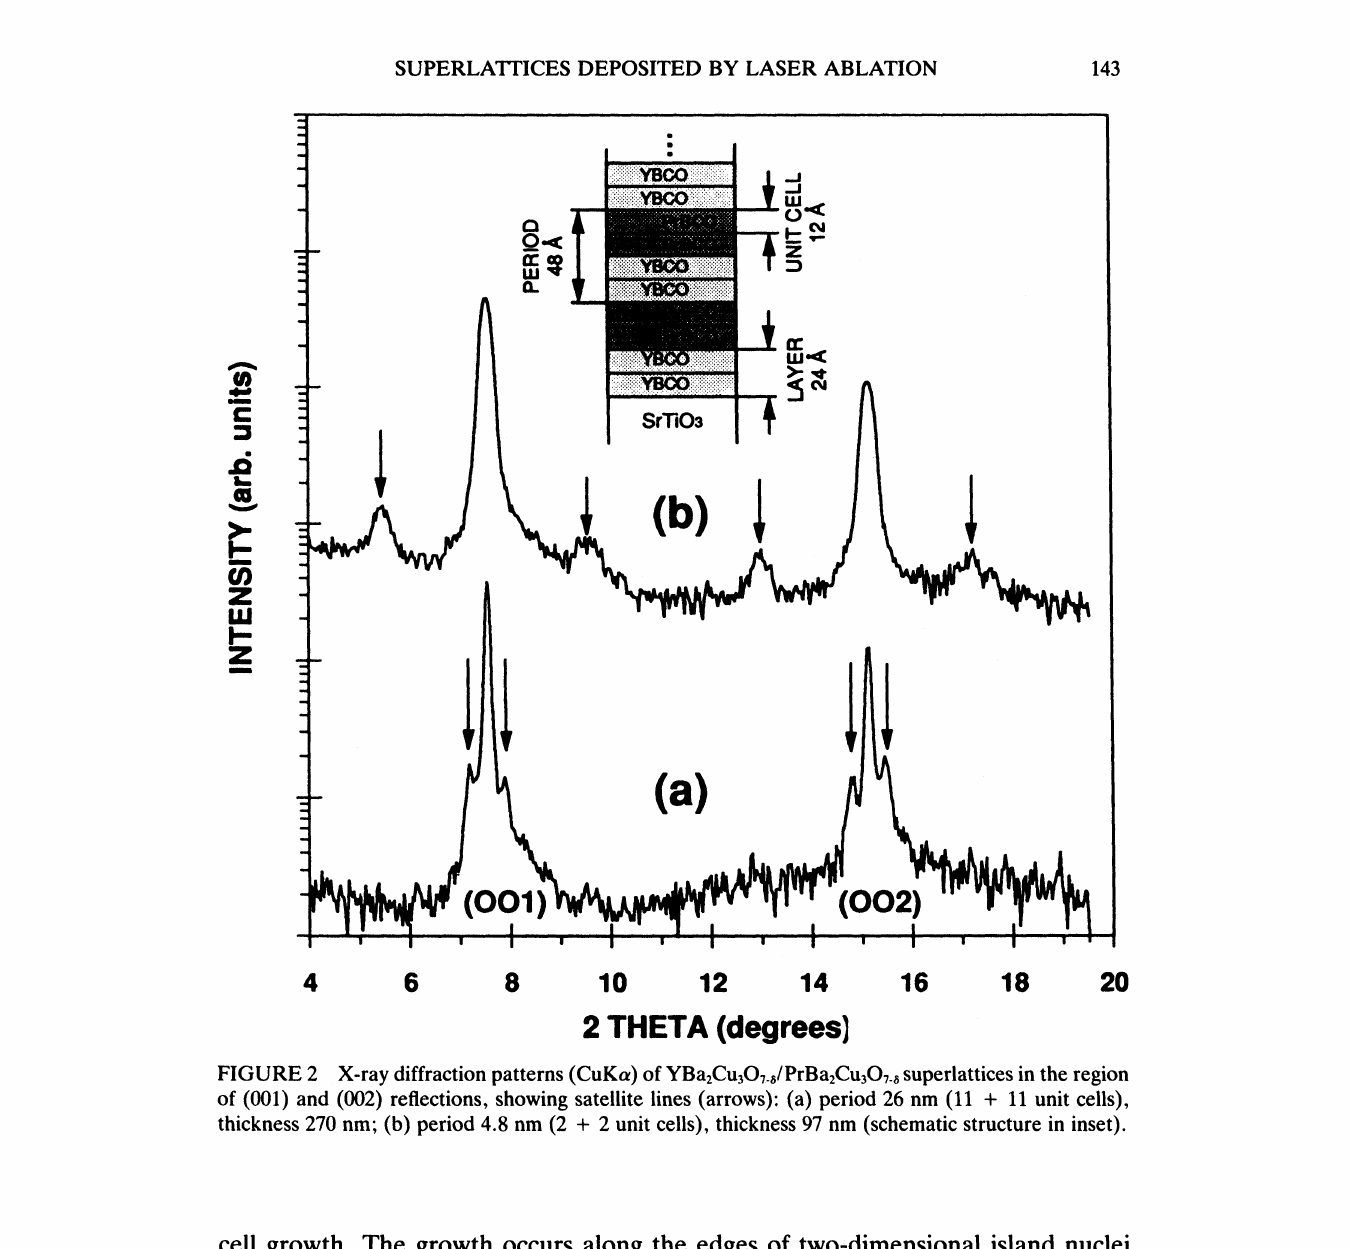
FIGURE 2 X-ray diffraction patterns (CuKa) of YBa2Cu3OT.a/PrBa2Cu3OT. superlattices in the region of (001) and (002) reflections, showing satellite lines (arrows): (a) period 26 nm (11 + 11 unit cells), thickness 270 nm; (b) period 4.8 nm (2 + 2 unit cells), thickness 97 nm (schematic structure in